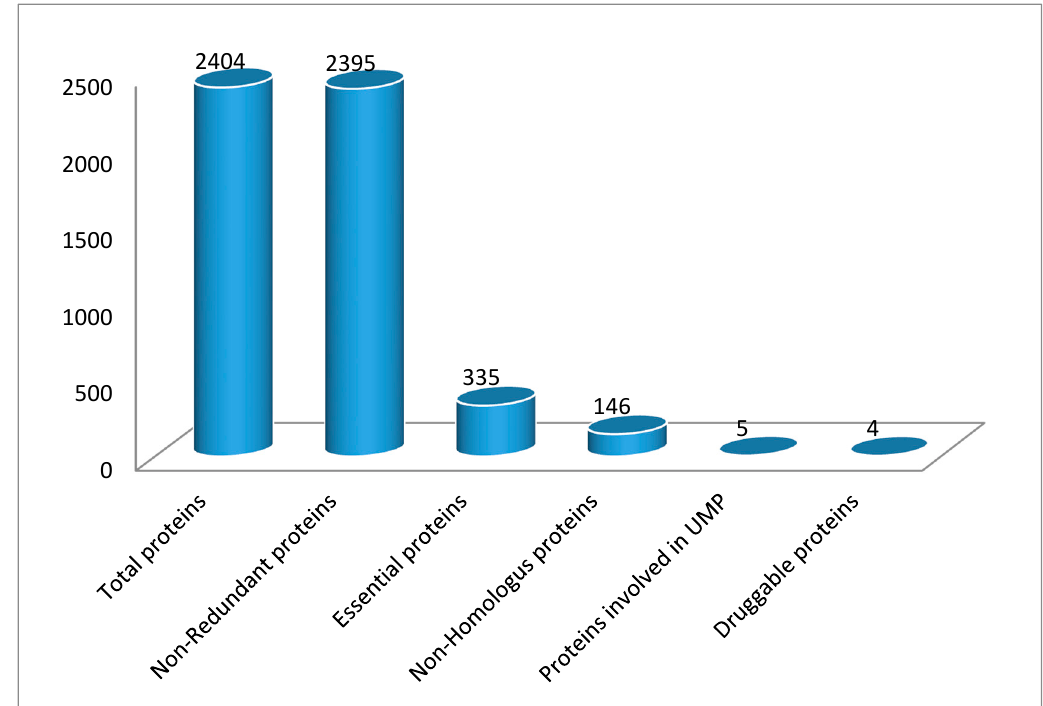
Figure 1. Summary for the detection of novel drug targets in Staphylococcus saprophyticus .